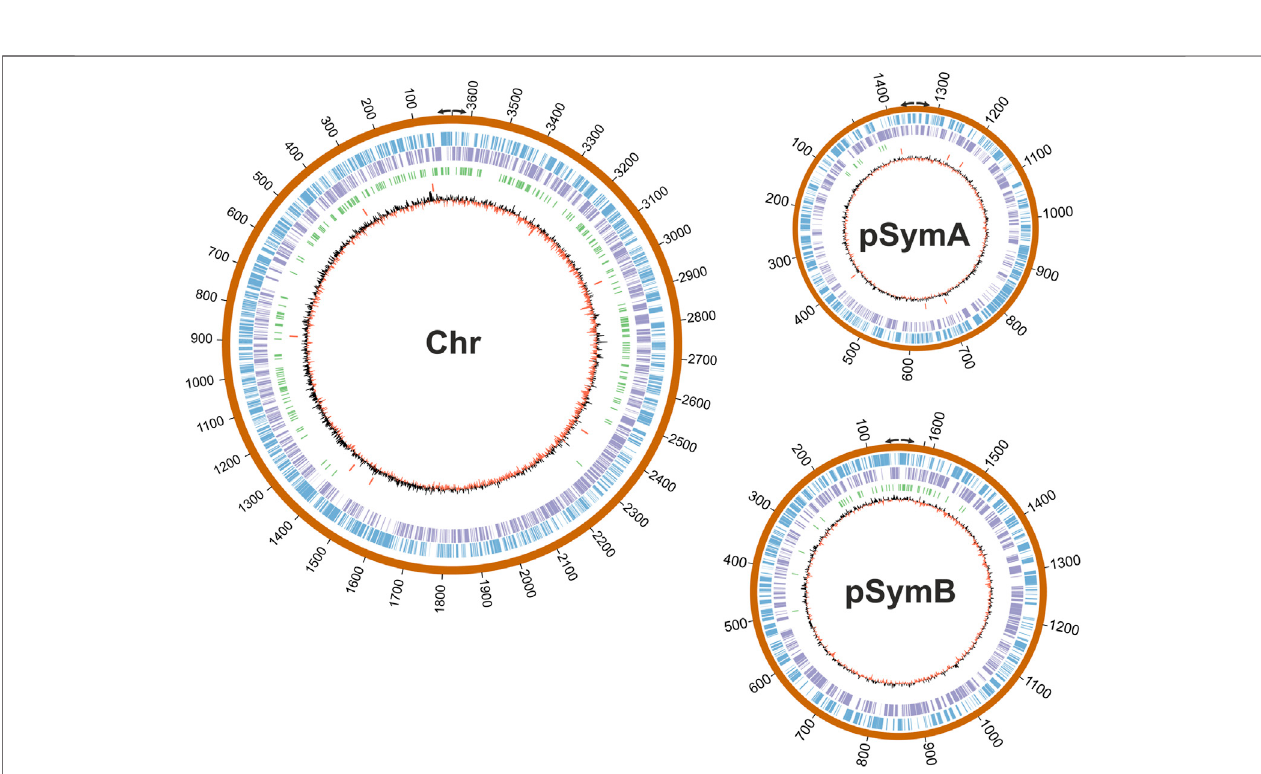
FIGURE 5 | Mapping of the RmInt1 binding sites in the S. meliloti RMO17 genome. The three replicons are drawn to scale with CIRCOS. The outer track in blue corresponds to the forward annotated genes (top strand) and the purple circle corresponds to the reverse orientation genes (bottom strand). Identi fi ed ChIP-Seq peaks are shown in green and the 13 copies of the natural target sequence of RmInt1 (ISRm20011-2) are indicated using red bars. The skewed GC plot is shown in red/black lines. Divergent arrows indicate the replication origin of each plasmid according to the data published by Lato and Golding